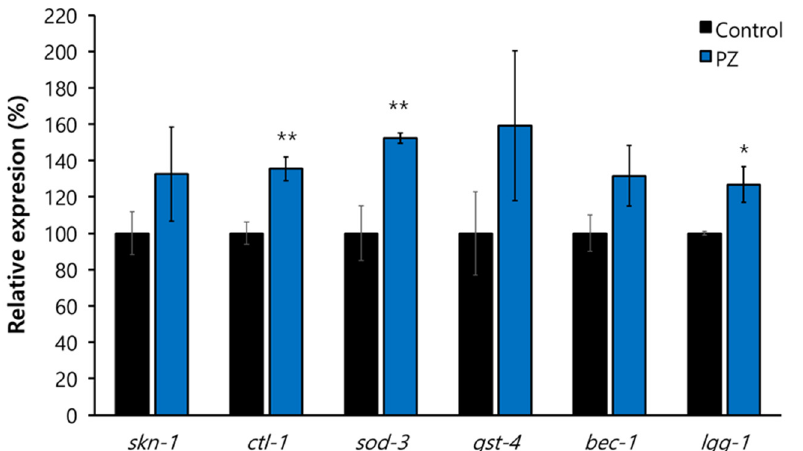
Figure 7. Underlying mechanisms involved in phlorizin-induced longevity. Lifespans of known long-lived mutants, age-1 ( A ), clk-1 ( B ), and eat-2 ( C ), were monitored with or without supplementation with phlorizin. ( D ) Effect of phlorizin on lifespan was examined when expression of daf-16 or bec-1 was repressed by RNAi. PZ, phlorizin (10 μ M); EV, empty vector.